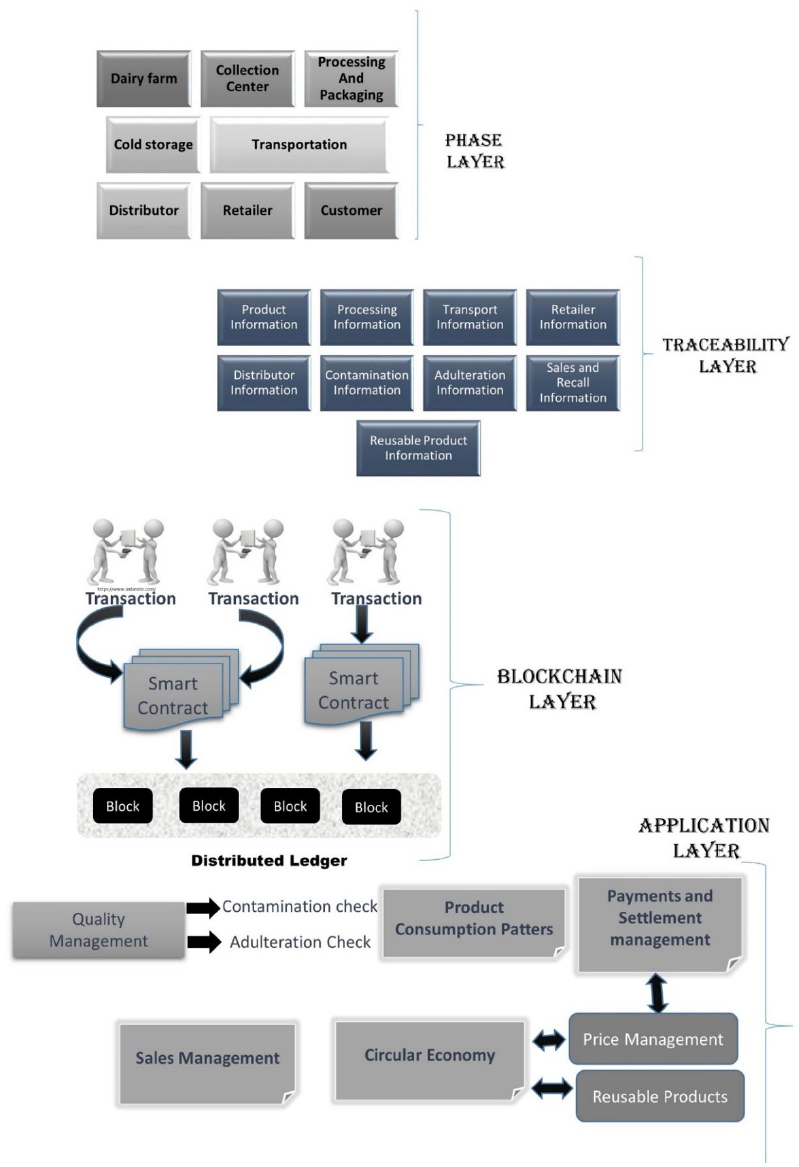
Figure 4. System architecture for the proposed blockchain-enabled supply chain platform for food safety and traceability.